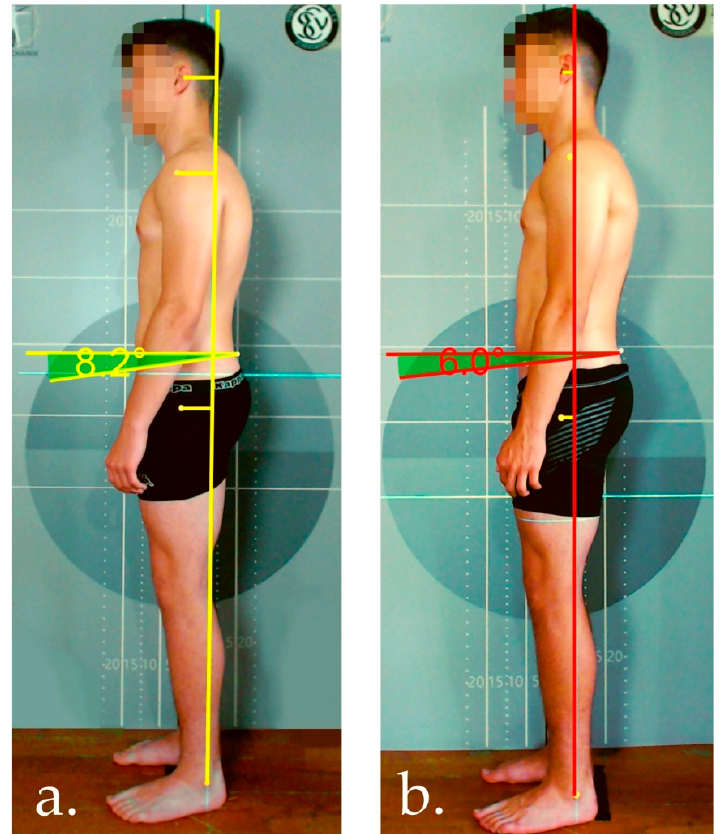
Figure 4. Typical example of the change in a participant’s habitual posture ( a : pre-test; b : post-test). As a measure against protracted head, the longus colli, obliquus capitis, and longus capitis muscles were strengthened via Exercises 1 and 8 (Table 3). For retraction of the shoulders, it was additionally and synergistically important to strengthen the rhomboid, latissimus dorsi, and trapezius muscles, which were activated in Exercises 1, 2, and 5. This is consistent with the findings of Ruivo et al. [28], who were able to improve head and shoulder position in adolescents through a 16-week strength and stretching programme, and also with the work of Sheikhhoseini et al. [29], who were able to demonstrate the effect of appropriate interventions on head position.